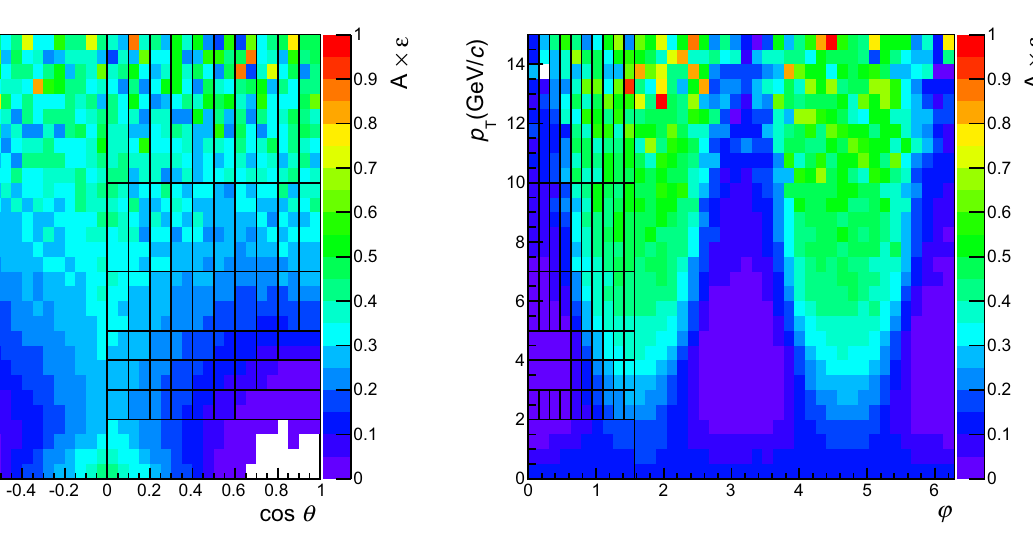
together with the results of the simultaneous fit (see text for details). Vertical bars correspond to statistical